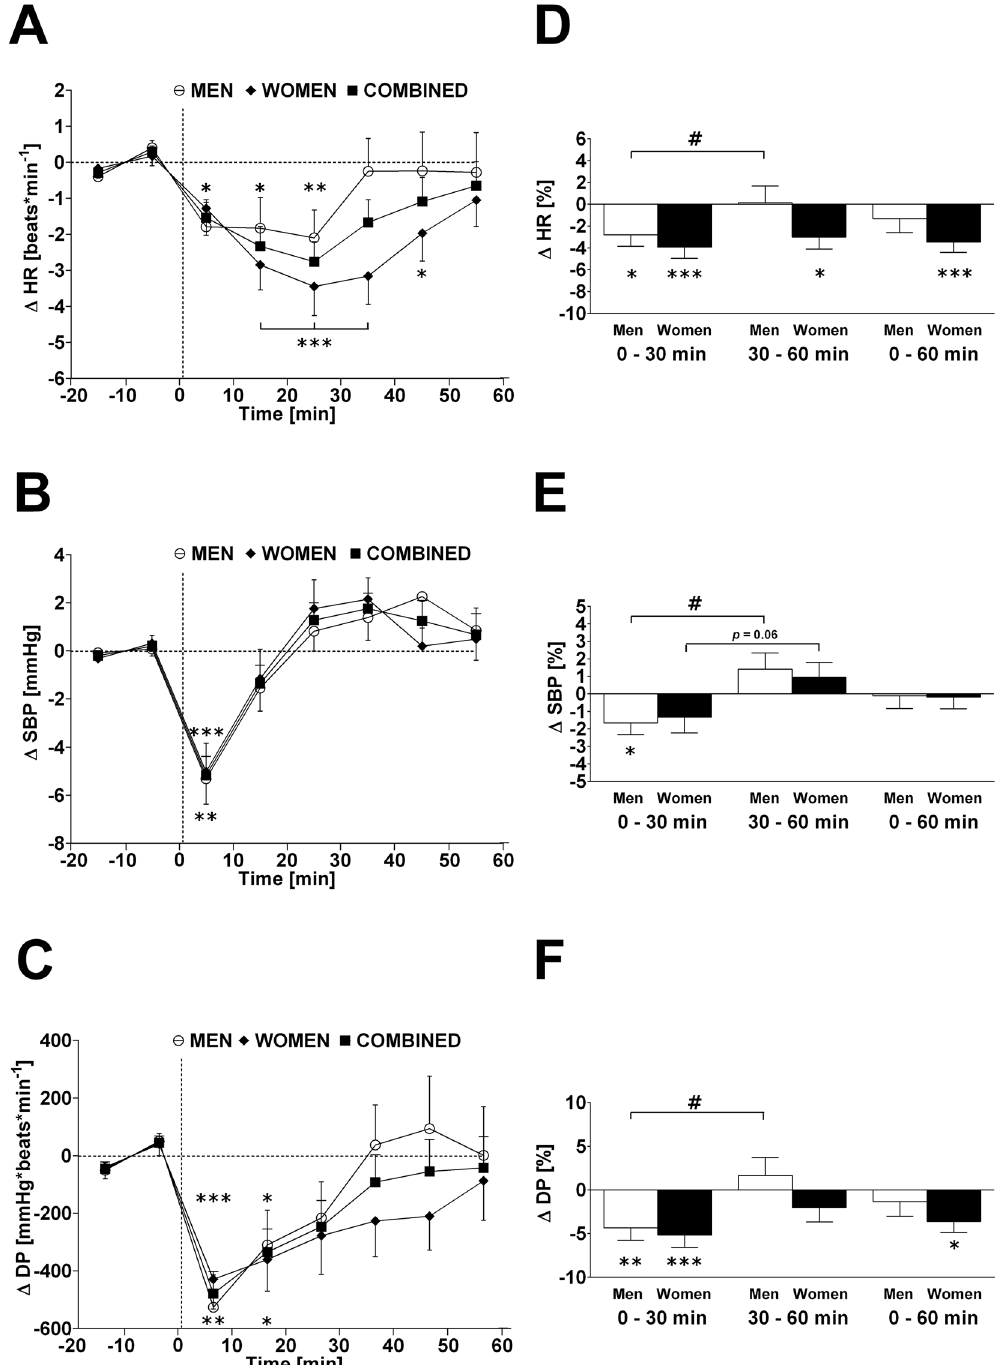
Figure 1. Left panels A–C: Time course of changes ( Δ ) from baseline in heart rate (HR), systolic blood pressure (SBP) and double product (DP), respectively. Open circle ( ○ ) = men; closed diamond ( ♦ ) = women; closed square ( ■ ) = combined men and women. Right panels D, E, F represent mean percentage changes in HR, SBP and DP relative to baseline. Time 0 denotes four minutes after the water drink with calculating a subsequent average over the following 30 minutes, 30 to 60 minutes, and 0 to 60 minutes post-drink, respectively, which were subtracted from each baseline level and presented as deltas. * P < 0.05, ** P < 0.01 and *** P < 0.005 statistically significant differences over time from baseline values (left and right panels), # P < 0.005 statistically significant difference between 0–30 min and 30–60 min post-drink period (right panel). All values are reported as means ±